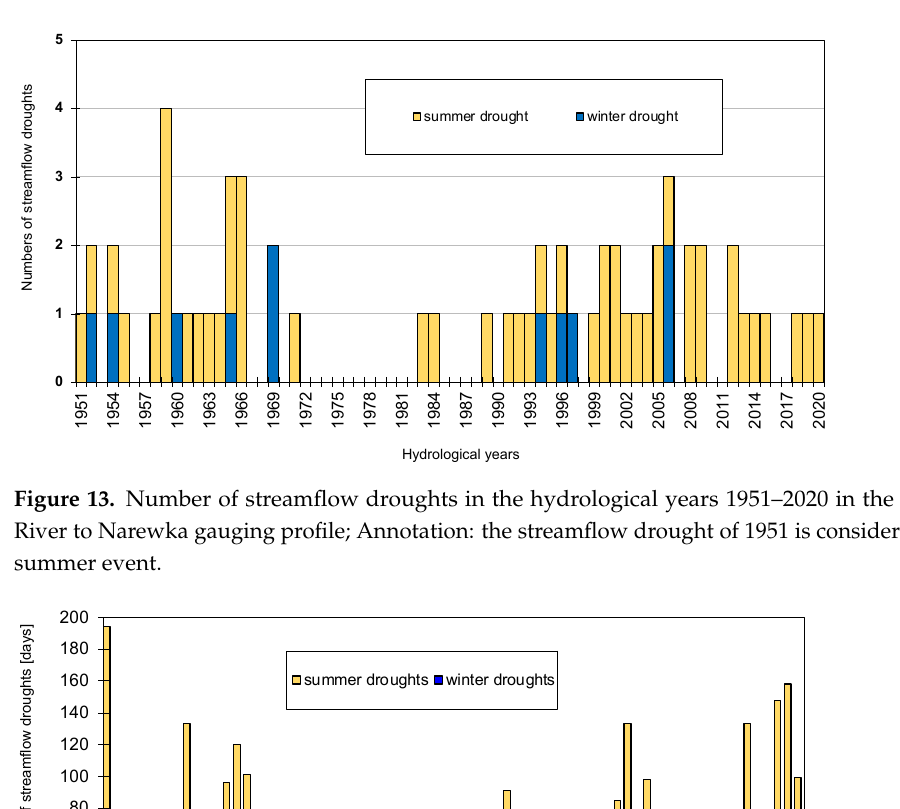
Figure 15. Deficit of streamflow droughts in the hydrological years 1951–2020 in the Narewka River to Narewka gauging profile; Annotation: the streamflow drought of 1951 is considered to be a summer event. Table 2. Characteristics of streamflow droughts in Narewka River in the period 1951–2020, and streamflow droughts in the years 1951, 2015, 2018, 2019, and 2020.